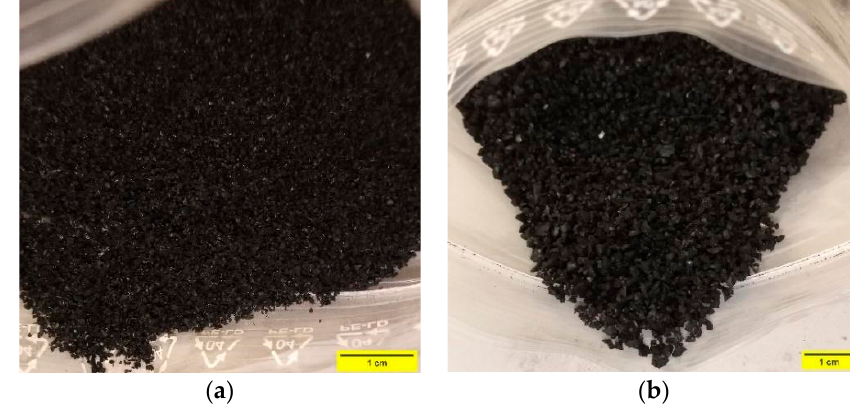
Figure 2. Photographs of ( a ) RP and ( b ) RG.